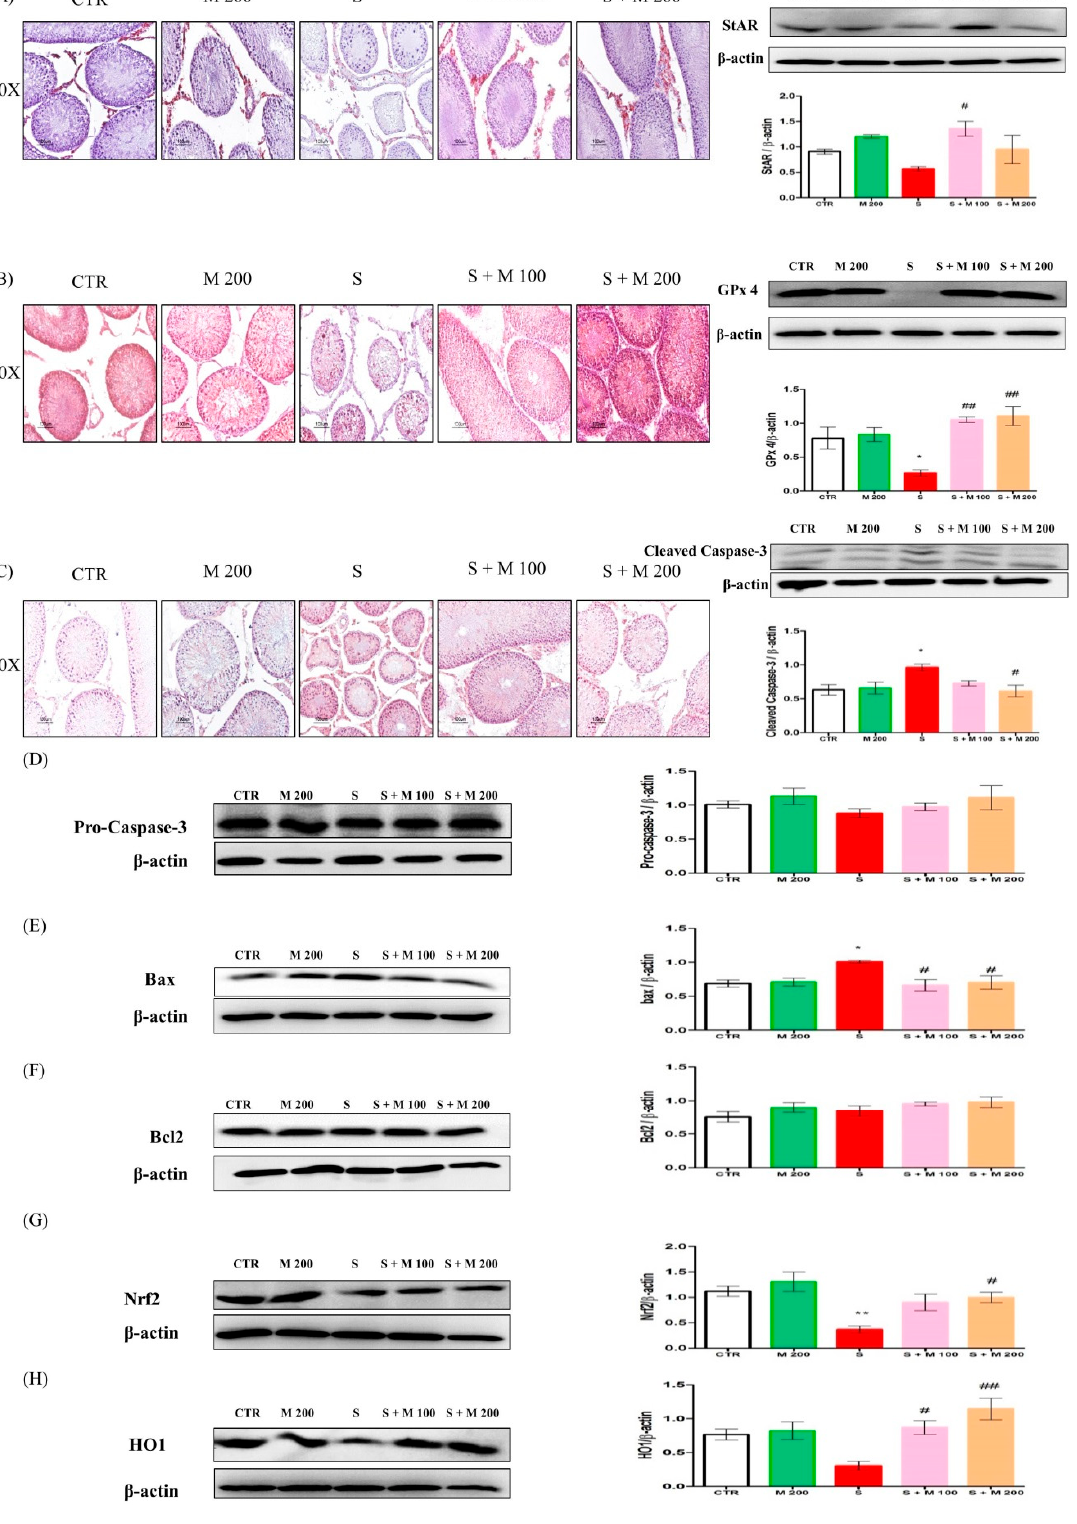
Figure 4. Effect of MOTILIPERM on testicular protein levels in immobilization stress-treated male Sprague Dawley rats determined by Western blot analysis and immunohistochemical staining. ( A ) Steroidogenic acute regulatory protein (StAR), ( B ) glutathione peroxidase-4 (GPx 4), ( C ) cleaved caspase-3, ( D ) Pro-caspase-3, ( E ) BCL2 associated X protein (Bax), ( F ) B-cell lymphoma 2 (Bcl2), ( G